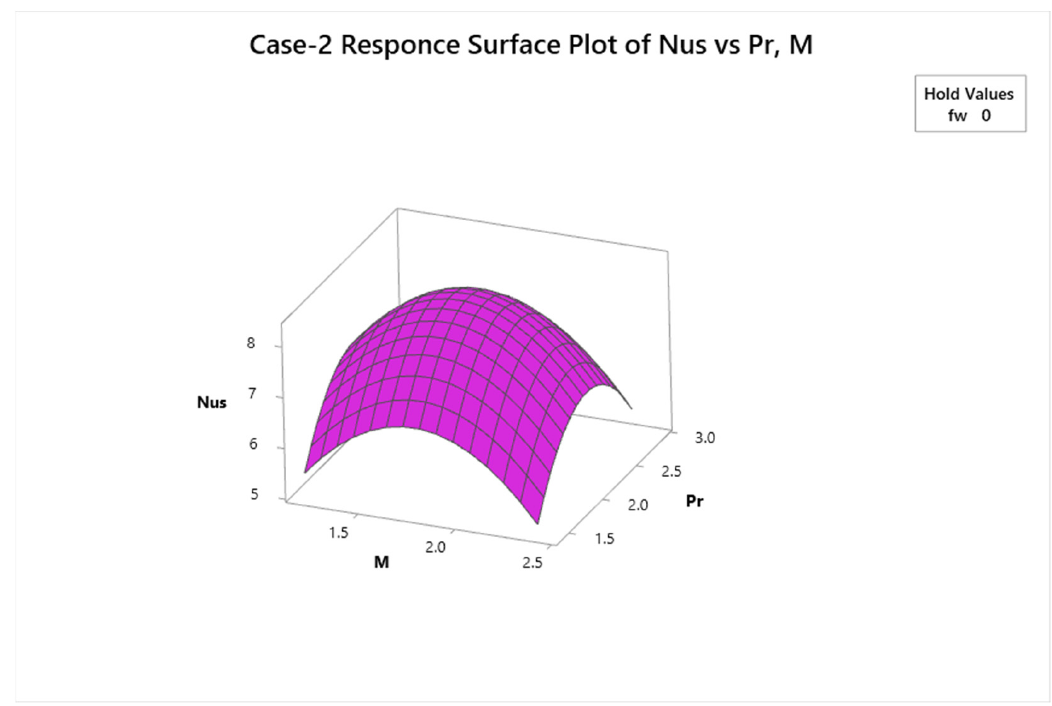
Figure 14. RSM plot for Nusselt number Vs Pr, M of Case-2.